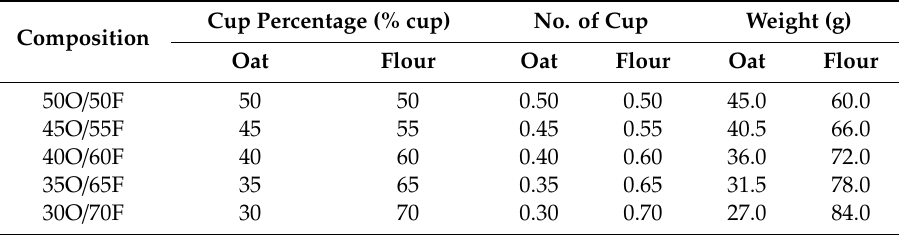
Table 6. Oat to flour composition, number of cups and weight of the oat and flour. Cup Percentage (% cup) No. of Cup Composition